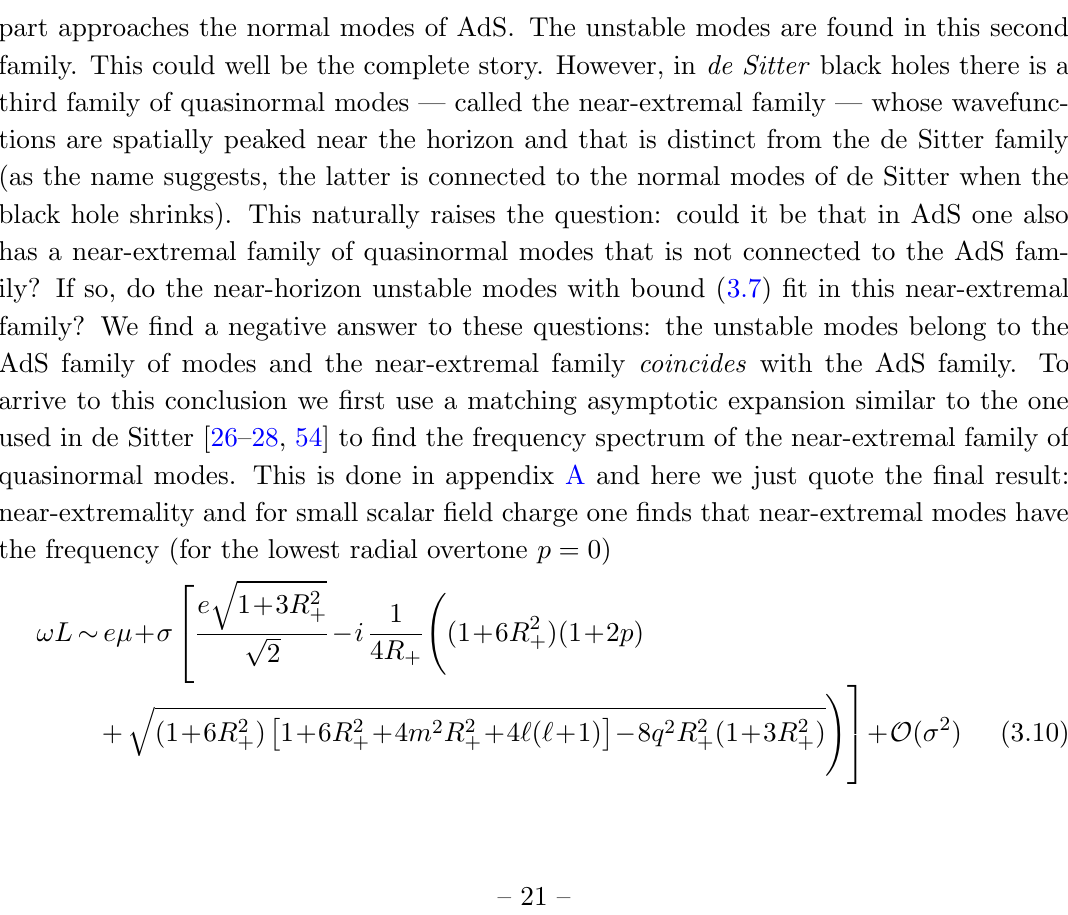
Figure 2 . Scalar (cid:12)eld frequency as a function of the dimensionless scalar charge qL for a AdS-RN black hole with (cid:22) = 0 : 99 (cid:22) ext and r + =L = 0 : 5 ( mL = 0 and ‘ = 1). Left panel : Imaginary part of the dimensionless frequency, Im( !L ). The system becomes unstable for q > q ? where q ? L (cid:24) 1 : 863. Right panel : Real part of the dimensionless frequency, Re( !L ), measured with respect to q(cid:22)L . This quantity changes sign at q = q ? , i.e. when Im( !L ) changes sign. In both plots, the black dashed curves describe the analytic prediction of the asymptotic matching expansion (A.10). We (cid:12)nd very good agreement with the numerical results (blue curves) for qL < 1 : 1 (say). This is a further justi(cid:12)cation of the crude assumption that we should match with 0 in the overlapping region. However we (cid:12)nd that these modes connect with the AdS normal modes as r + !